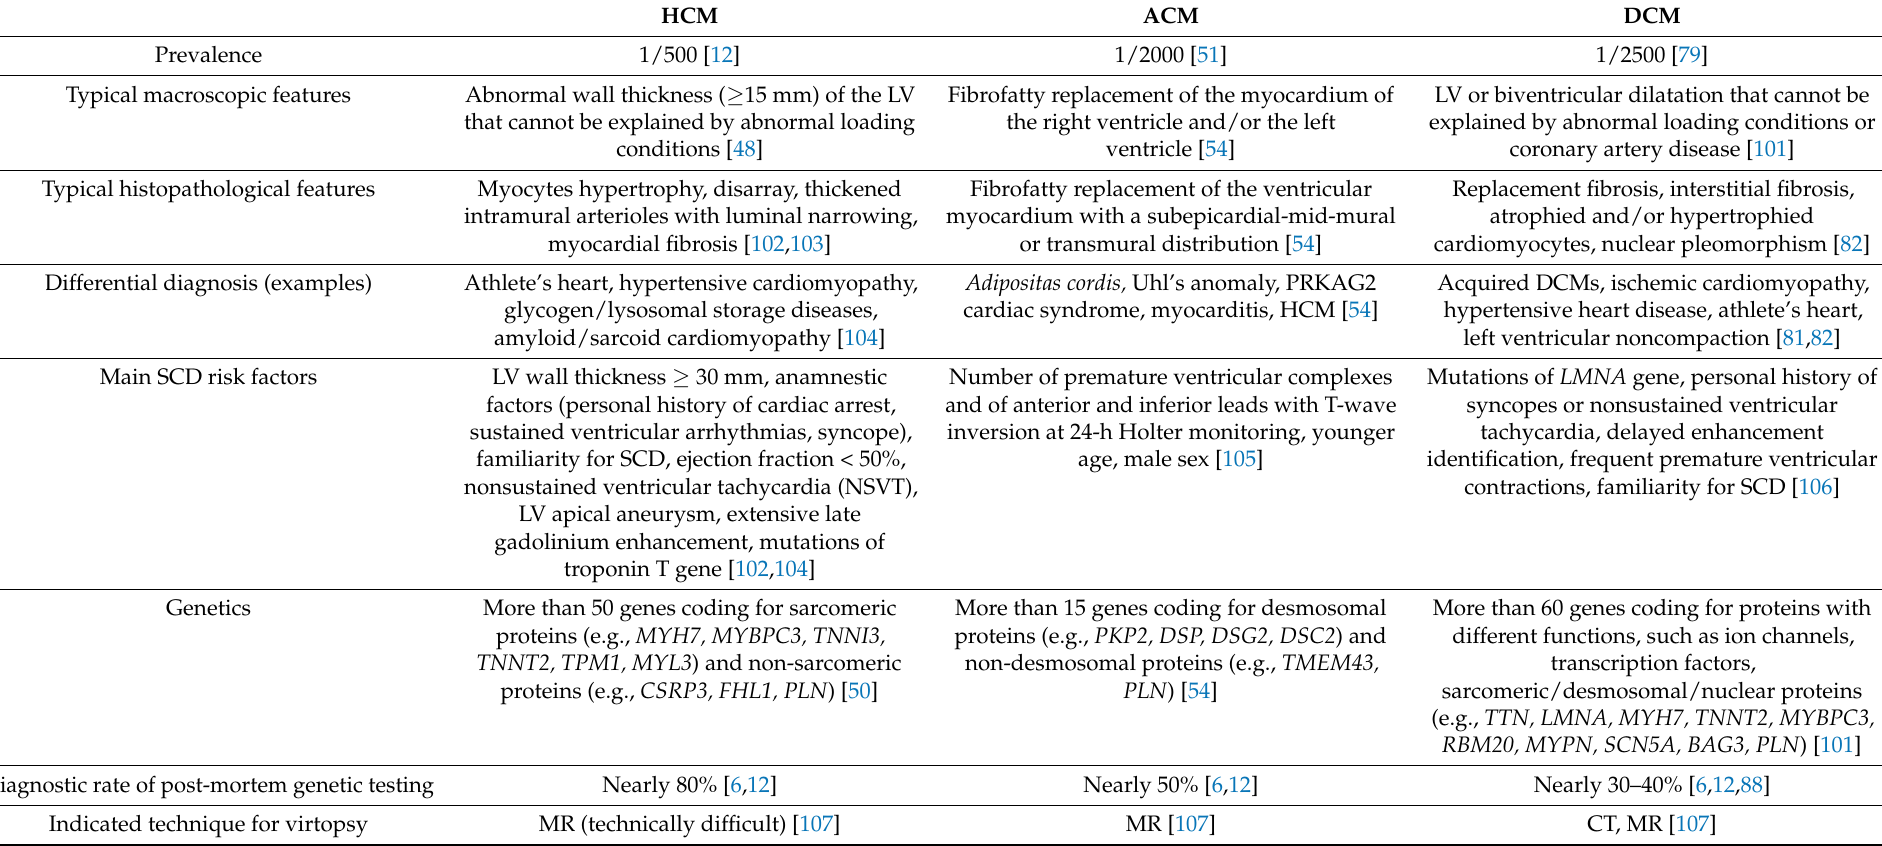
Table 1. The main features of inherited HCM, Arrhythmogenic Cardiomyopathy (ACM) and Dilated Cardiomyopathy